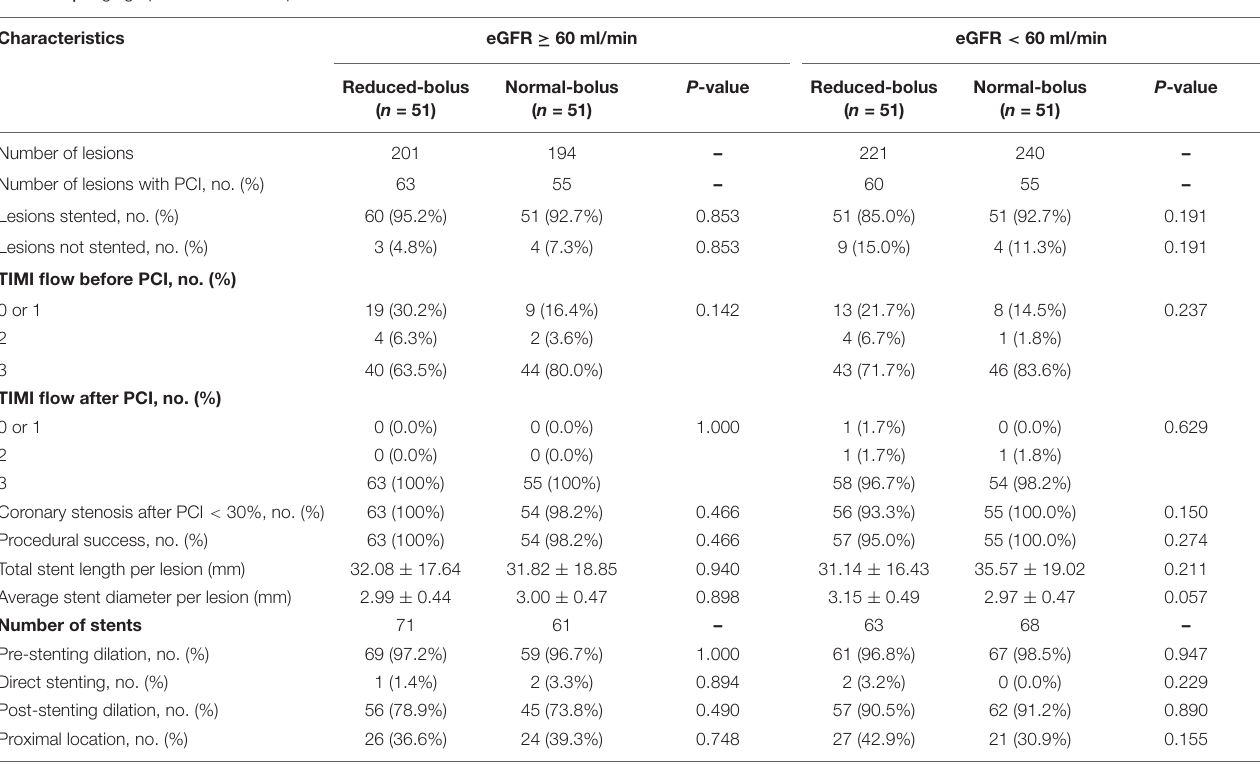
TABLE 4 | Angiographic lesion-based procedural